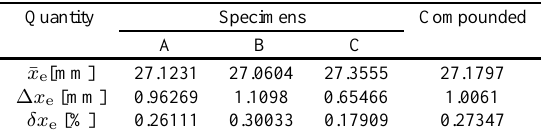
Table 1 Average position of extreme of damping force, absolute and relative standard deviation Quantity Specimens